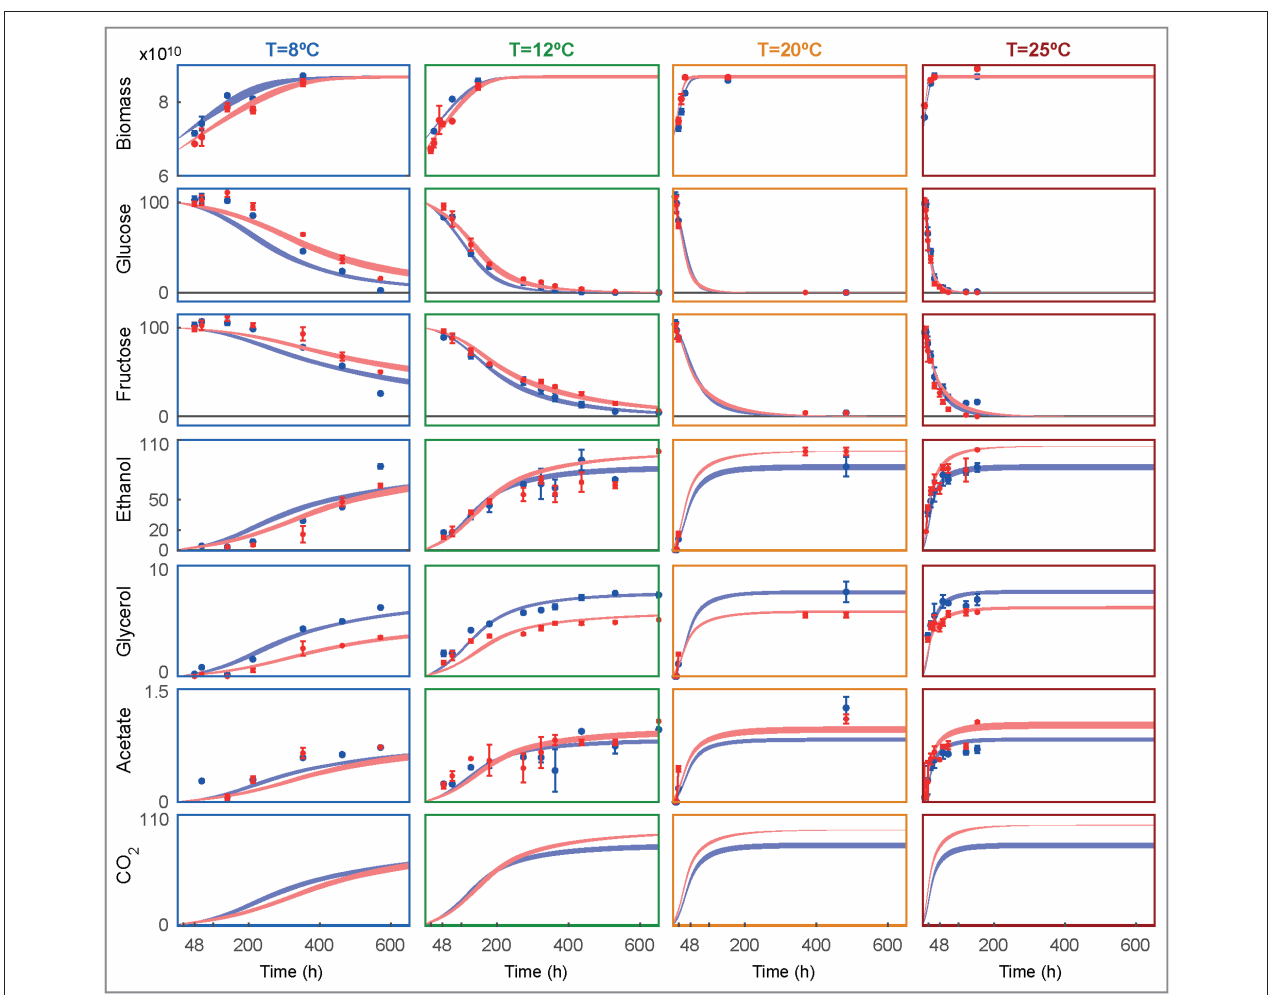
FIGURE 3 | Ensemble of time course predictions for both strains (rows) under different temperatures (columns) as compared to experimental data. The shaded bands depict the predicted non-symmetric 95 % confidence interval for SKCR85 (blue) and SCT73 (red). Biomass is shown in decimal logarithm scale (cells/L) while the metabolites are shown in